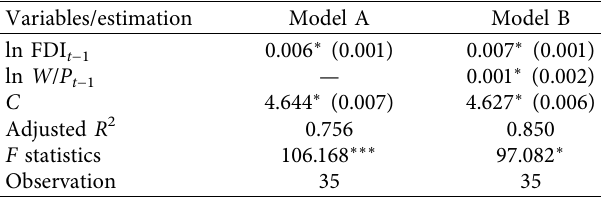
Table 3: Results of Model A and Model